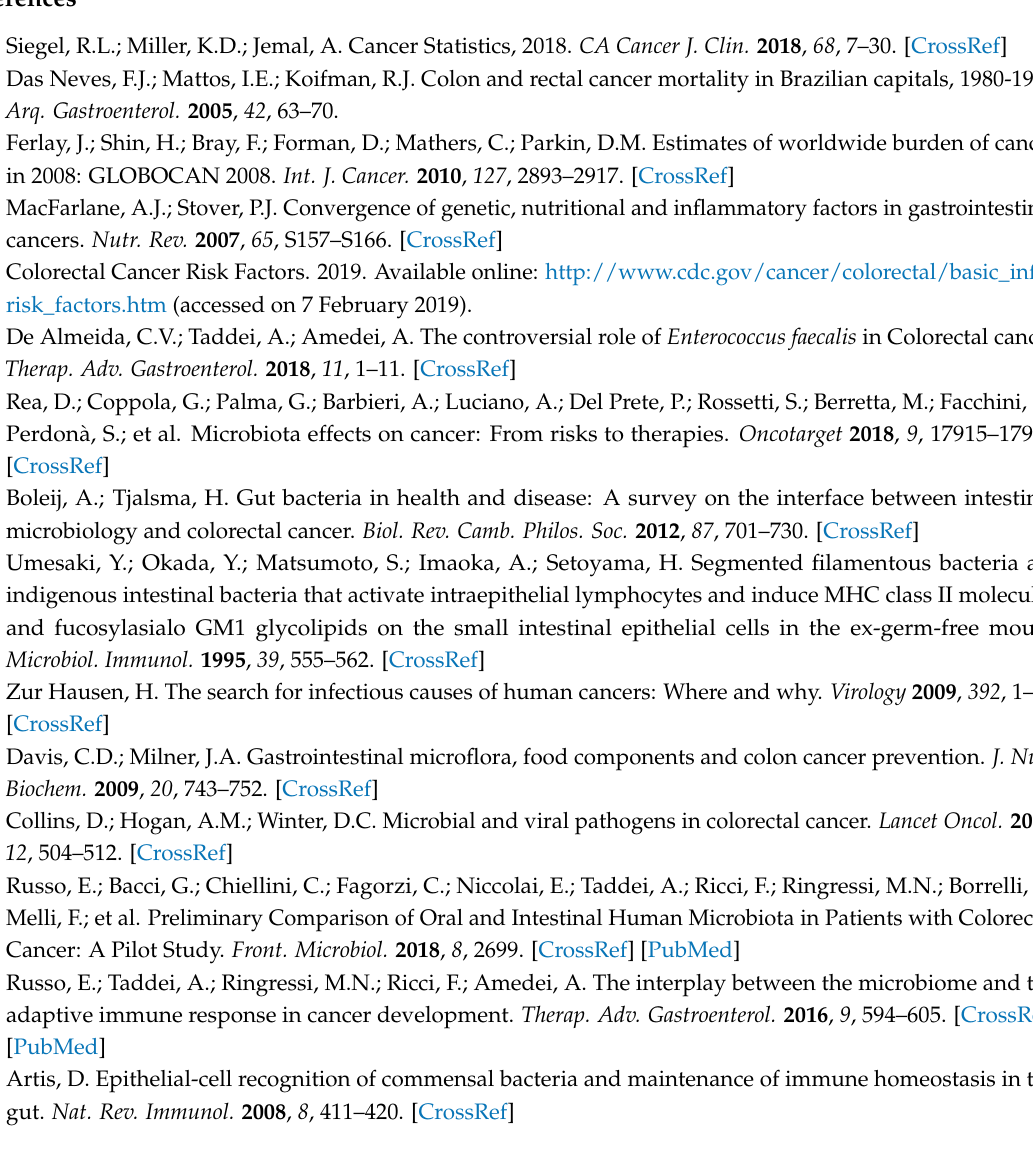
Figure S1: Cell cycle phase distribution of CLR1790 and HCT-116 cell lines after 48 h of bacterial metabolites exposure., Table S1: Genotypic characterization of the virulence factors of the different E. faecalis strains, Table